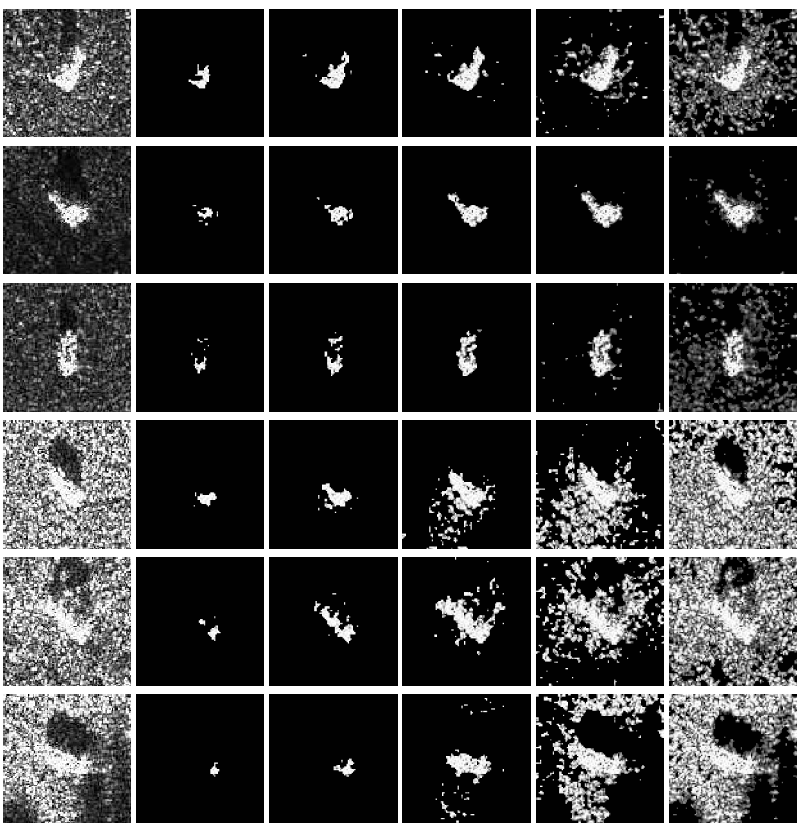
Figure 5. Insertion results generated by SC-SM CAM with different θ . The first column is the original SAR image. The second to the sixth columns are the inserted image when θ = 10%,